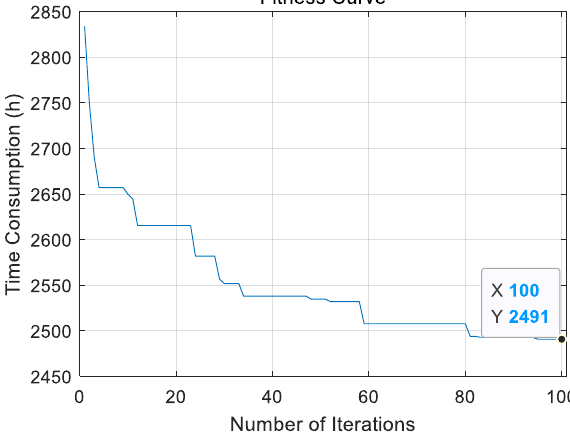
Figure 18. Objective function fitness curve. Table 5. The task quantity of each design subtask